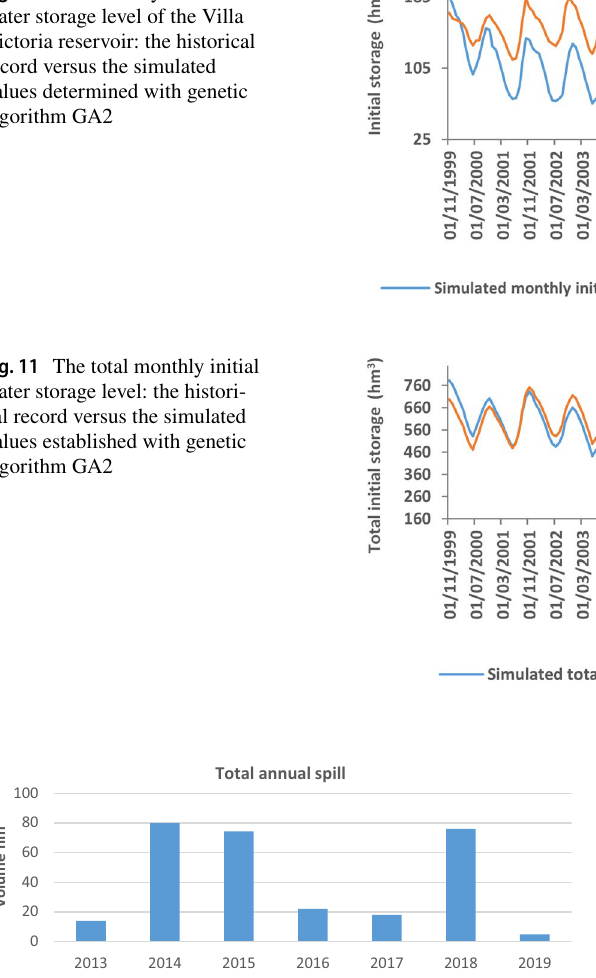
Fig. 23. The frequency of the distinct monthly average rates GA1, GA2, and GA3 policies is portrayed in Fig. 24.